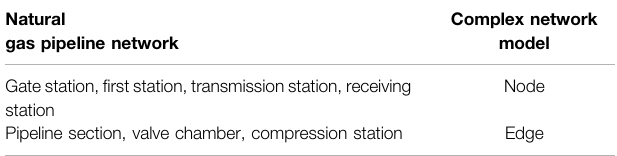
TABLE 1 | The relationship between the complex network and pipeline network table. Natural gas pipeline network